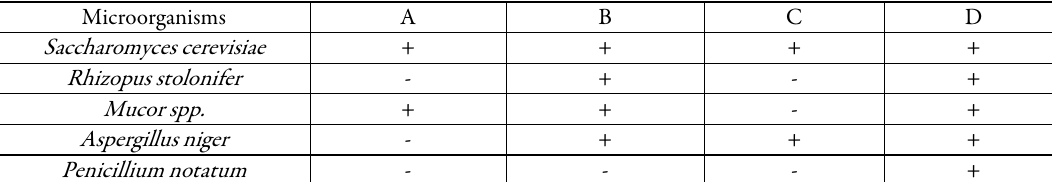
Table 5. Bacterial sensitivity test of isolates from bread samples Antibiotics